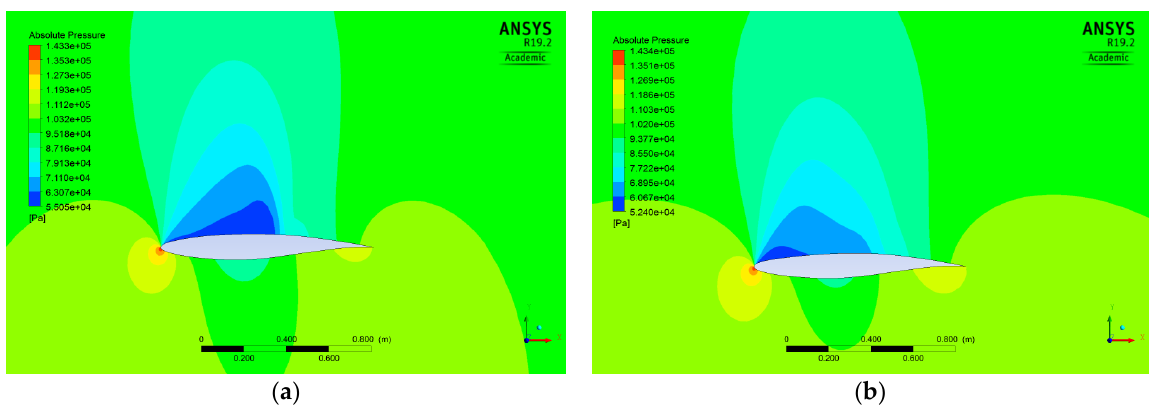
Figure 10. Absolute pressure distribution for the initial shape (RAE 2822) ( a ) and the optimal shape (at iteration 5) ( b ) for Test case I.